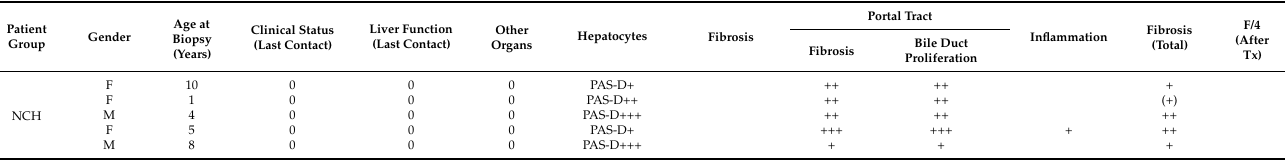
Table 1. Clinical and diagnostic characteristics of PiZZ